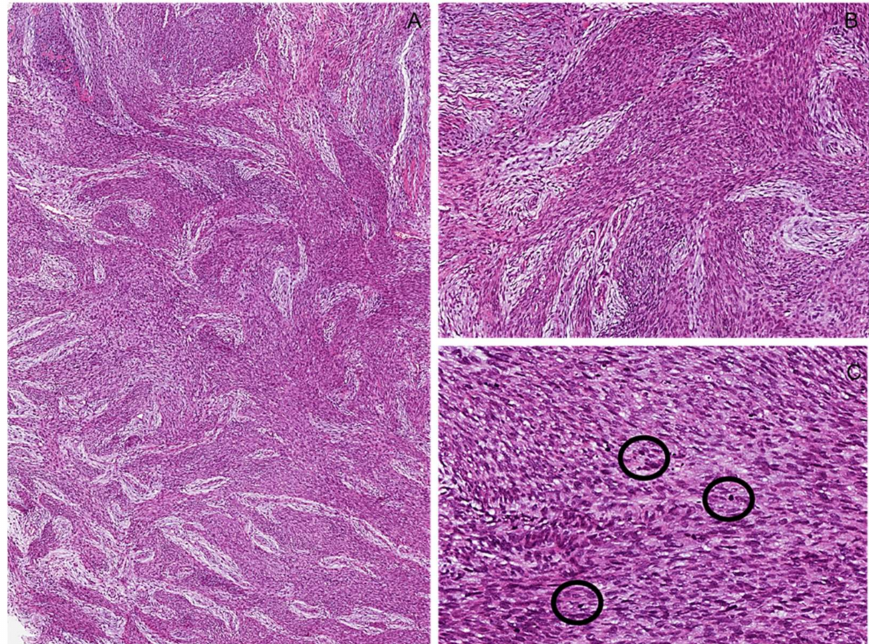
Figure 22. High-grade classic malignant peripheral nerve sheath tumor (MPNST). ( A , B ) Low- and medium-magnification images showing a hypercellular tumor composed of uniform spindled cells arranged in densely cellular fascicles, often alternating and interdigitating with more hypocellular and myxoid areas ( marble-like appearance). ( C ) Numerous mitoses (circles) are seen in high-grade